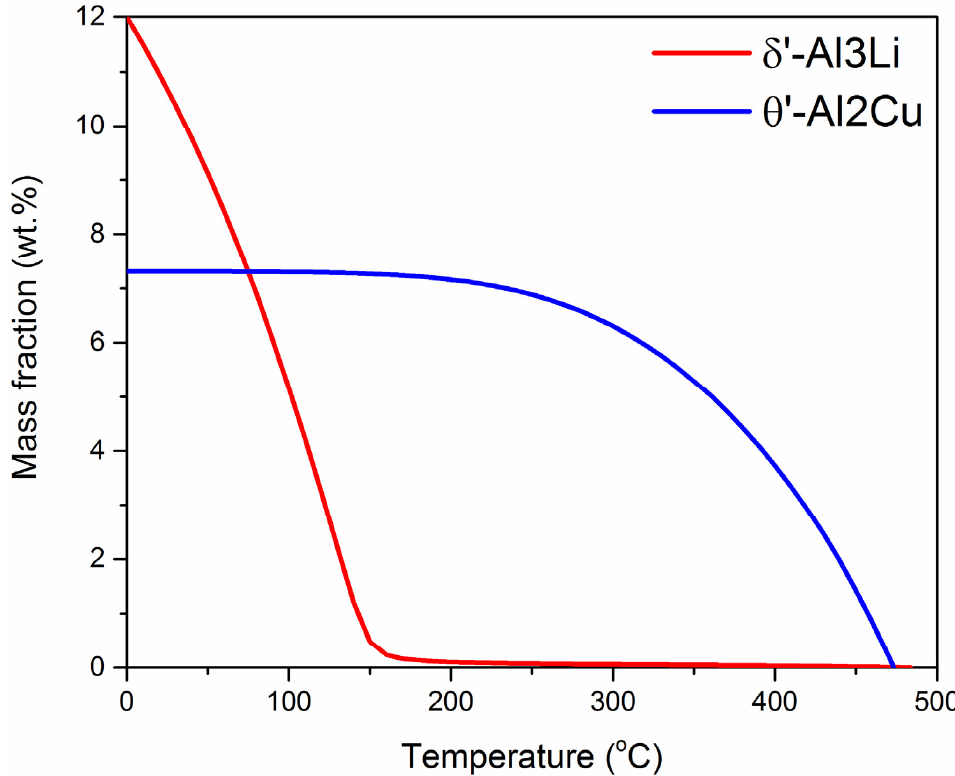
Figure 10. Calculated δ ’-Al3Li and θ ’-Al2Cu (removed T1-Al2CuLi).